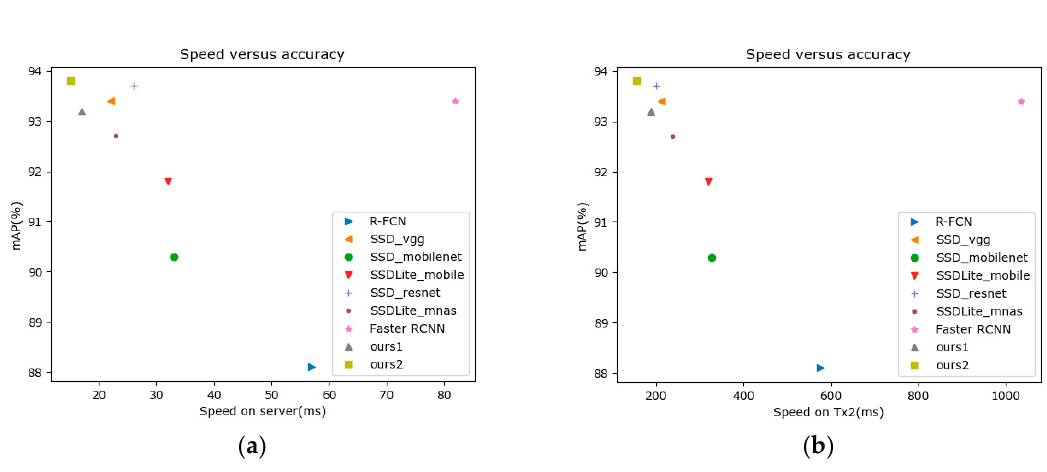
Figure 13. Speed versus accuracy: ( a ) test on the server; ( b ) test on TX2.